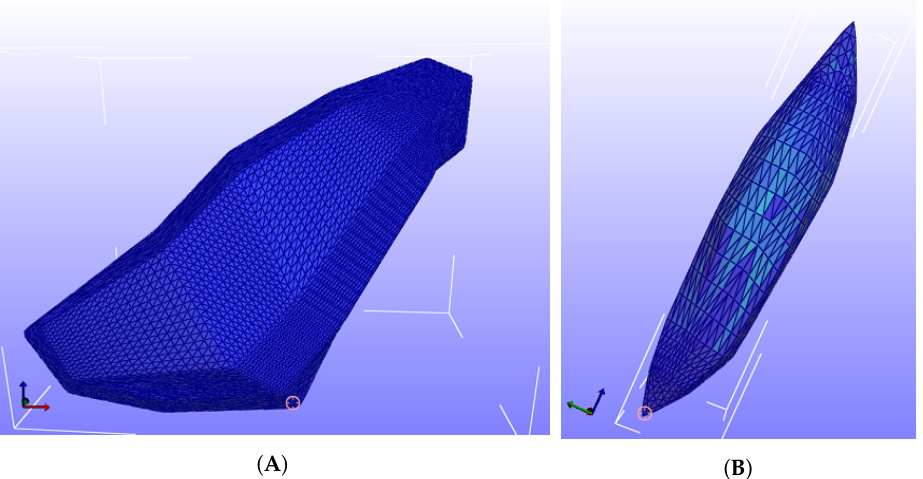
Figure 3. Tetrahedral elements for the triceps and the vastus lateralis. ( A ) shows the tetrahedral elements for the triceps, while ( B ) shows the tetrahedral elements for the vastus